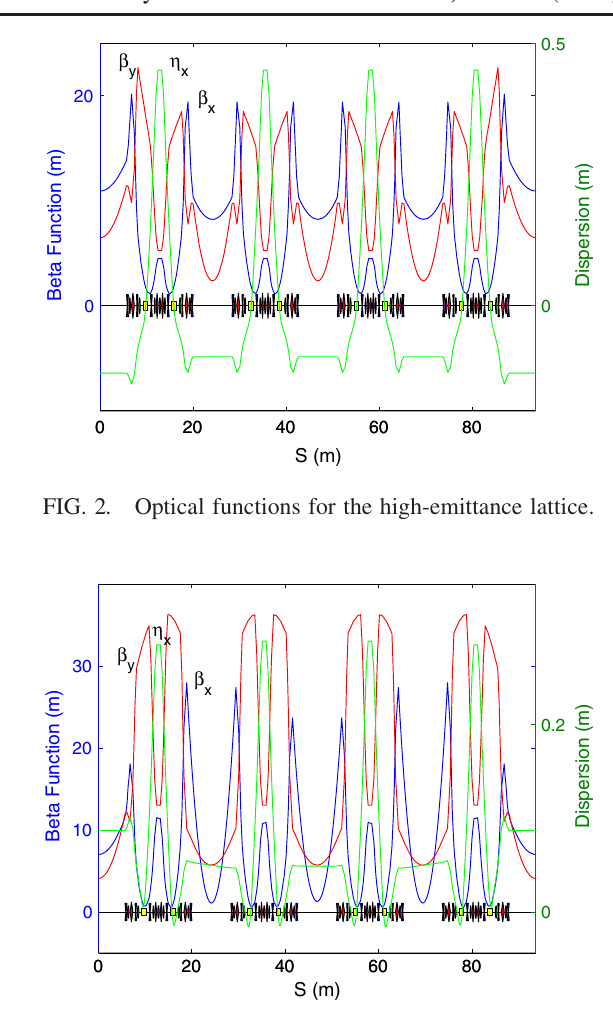
FIG. 3. Optical functions for the low-emittance